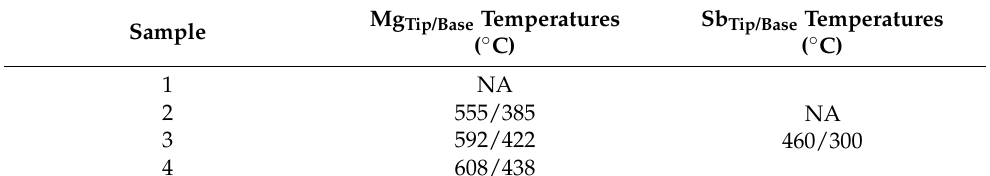
Table 1. Samples of Zn 1 − x Mg x O:Sb layers. NA-Non applicable.